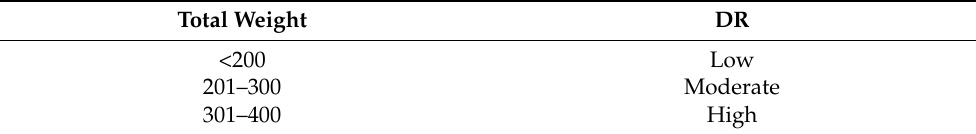
Table 3. Degradation risk (DR) classification